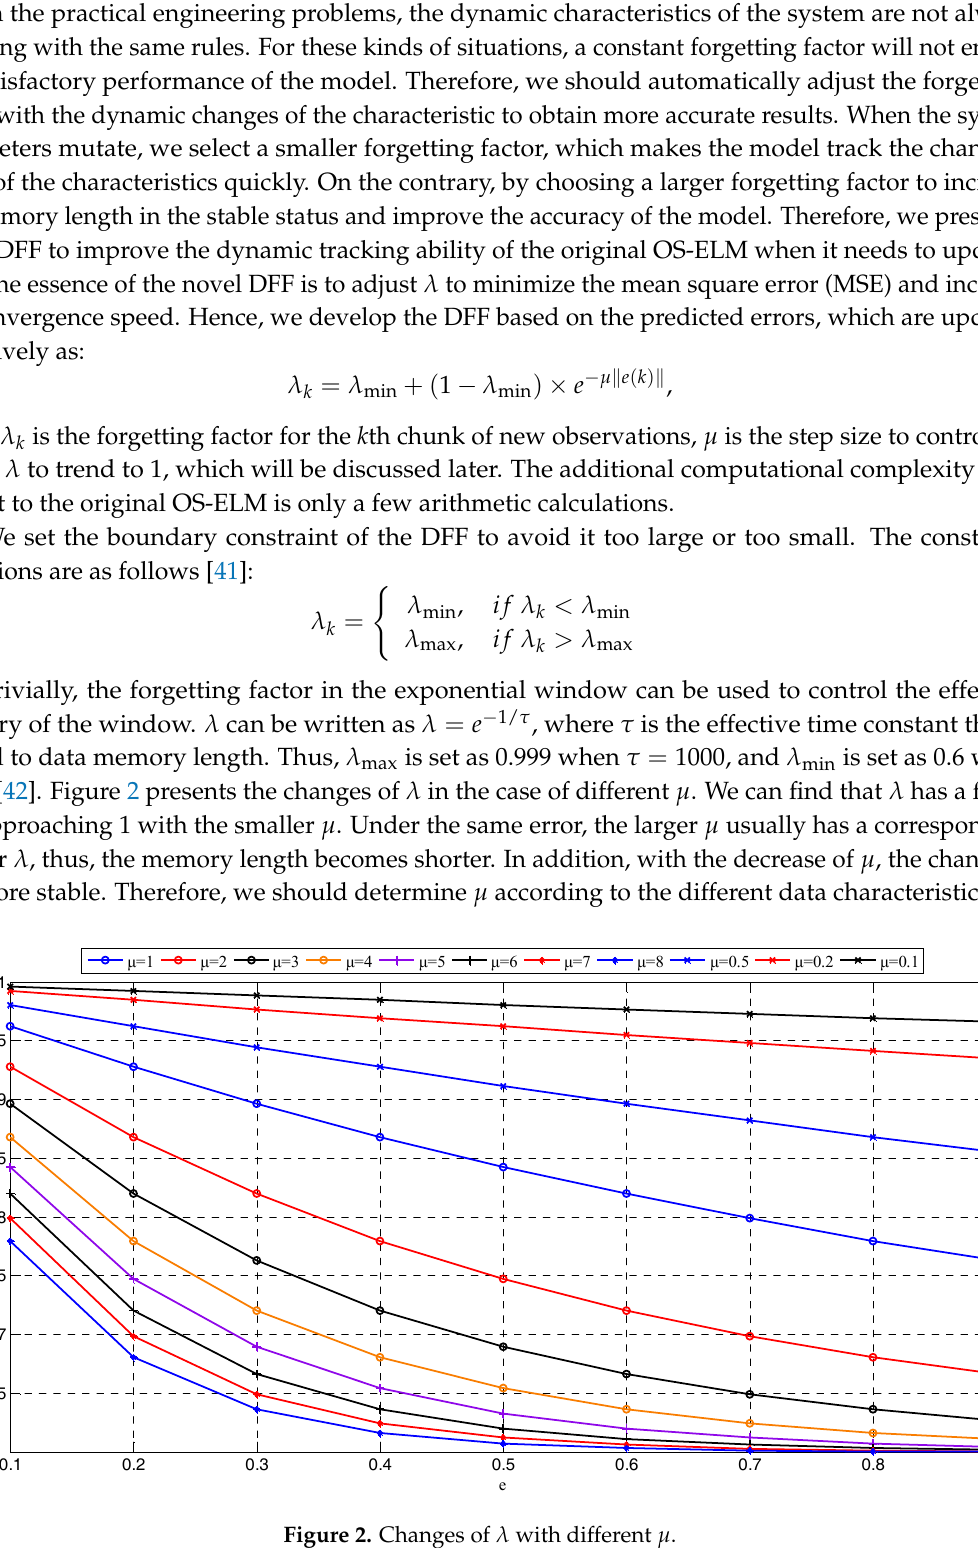
Figure 2. Changes of λ with different µ